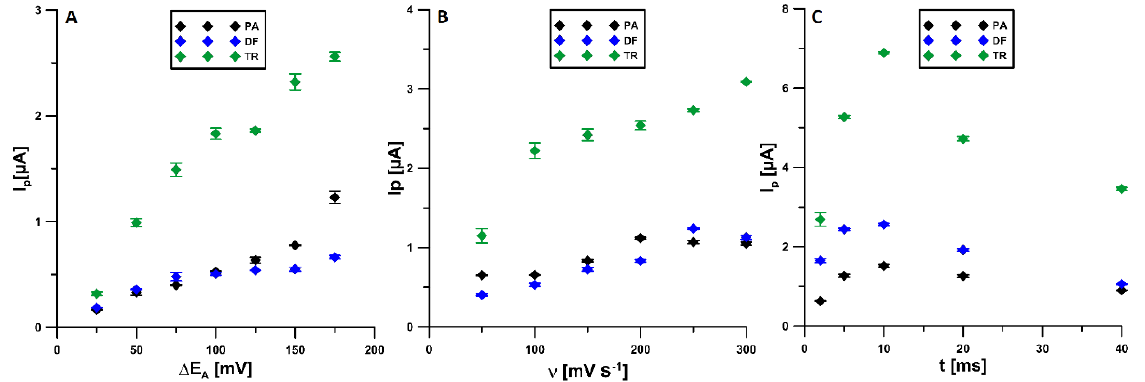
Figure 6. Influence of E acc. ( A ) and t acc. ( B ) on voltammetric response of 2 × 10 −6 mol L −1 PA, 1 × 10 −7 mol L −1 DF, and 1 × 10 −5 mol L −1 TR. The DPAdS V parameters: ΔE A of 50 mV, t m of 50 ms, and ν of 140 mV s −1 .